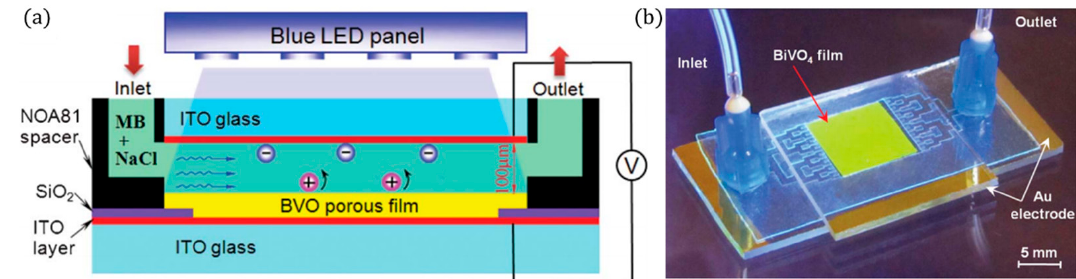
Figure 17. ( a ) Cross-sectional view of the reaction chamber, ( b ) photo of the PEC microreactor. (Adapted with permission from [49]: Wang, N.; Zhang, X.; Chen, B.; Song, W.; Chan, N.Y.; Chan, H.L.W. Microfluidic photoelectrocatalytic reactors for water purification with an integrated visible-light source. Lab Chip 2012 , 12 , 3983–3990, doi:10.1039/c2lc40428a. Copyright (2012), Royal Society of Chemistry Publishing (Cambridge, UK)).